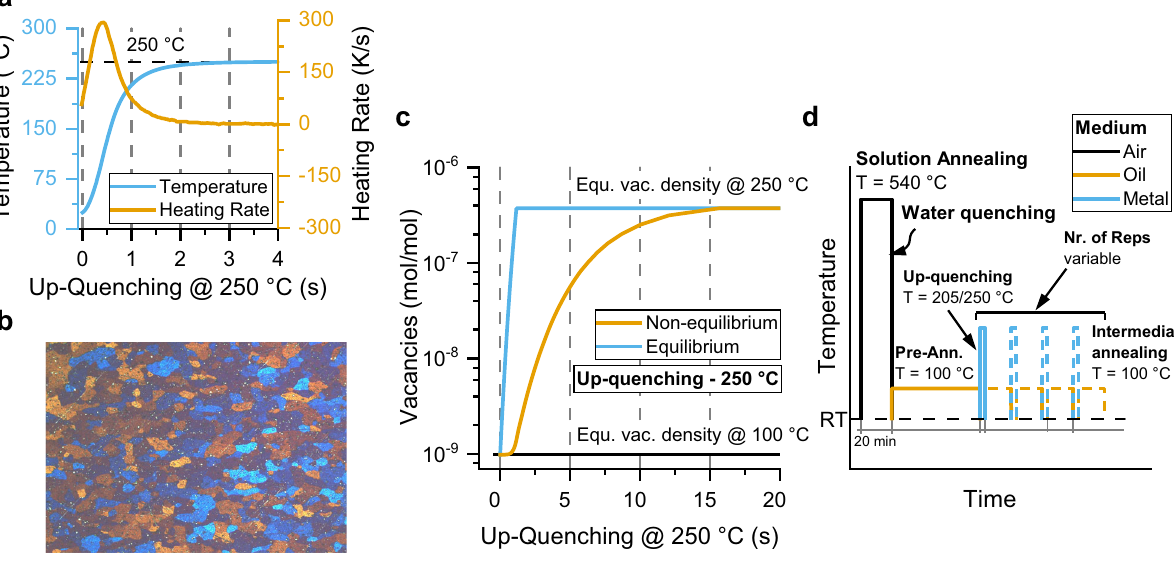
Fig. 1 Input parameters and thermo-kinetic simulations for the design of combined heat treatments using up-quenching. a Thermal pro fi le of a 1.7-mm thick sheet upon immersion into a metal bath at 250 °C, measured with an embedded Type K thermocouple. This simulates up-quenching. b Grain structure of the commercial EN AW-6016 sheet used in T4 state (the scale bar corresponds to 500 μ m). c Simulated vacancy evolution during up-quenching at 250 °C at a heating rate of 130 K/s with the grain boundary and dislocation jogs as the major vacancy sources. More than 10 s are required to generate a considerable number of vacancies (~75% of the equilibrium value). d Schematic illustration of the combined heat treatment.